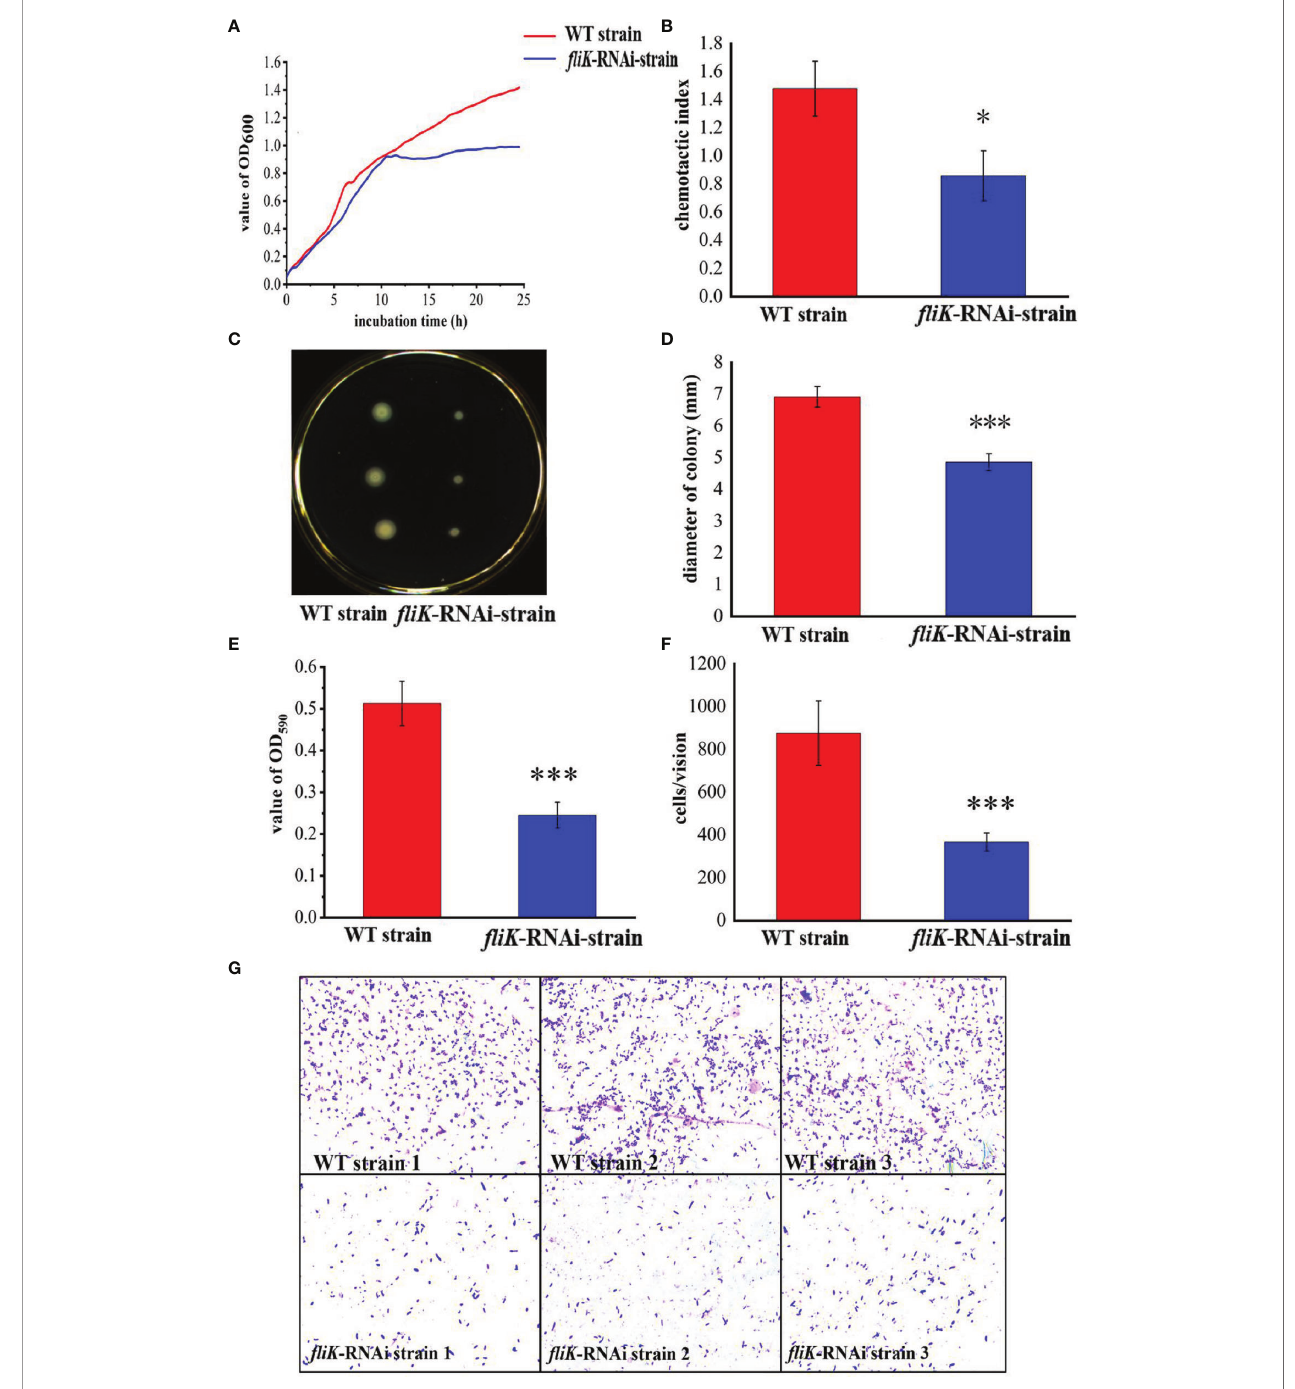
FIGURE 2 | Comparison of biological characteristics between WT and fl iK -RNAi strains of P. plecoglossicida . (A) Growth curve of WT and fl iK -RNAi strains. (B) Colonies of WT and fl iK -RNAi strains on semi-solid agar. (C) Colony diameter of WT and fl iK -RNAi strains. (D) Adherent bacterial cells of WT and fl iK -RNAi strains under light microscope (×1 000, crystal violet staining). (E) Number of cells of WT and fl iK -RNAi strains attached to fi sh mucus. (F) Chemotaxis index of fi sh mucus against WT and fl iK -RNAi strains. (G) Level of bio fi lm formation in WT and fl iK -RNAi strains. Data are means ± SD from three independent biological replicates. * P < 0.05, *** P <